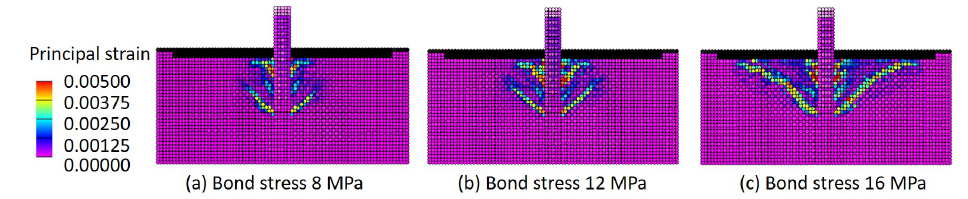
Figure 11. Effect of adhesive stress on the fracture